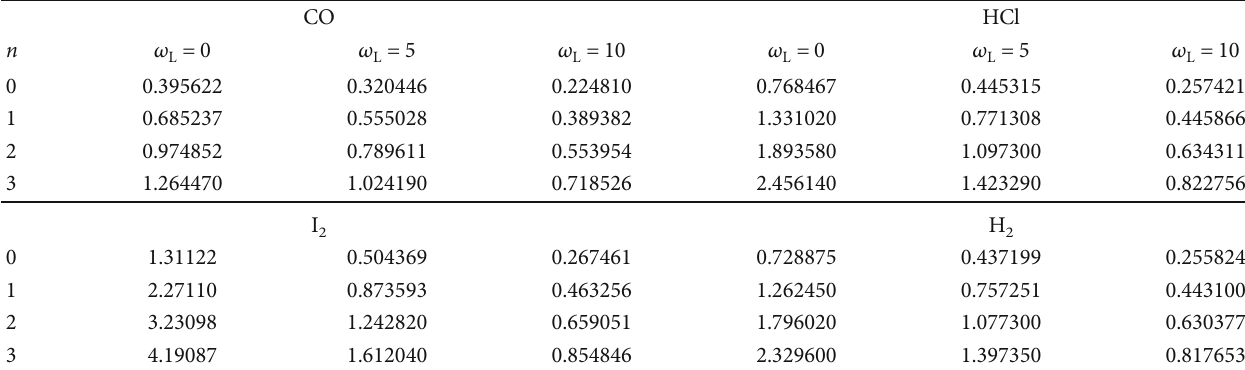
, and H molecules bounded by the isotropic oscillator plus inverse quadratic potential for 2 2 with g = m = 1 . L